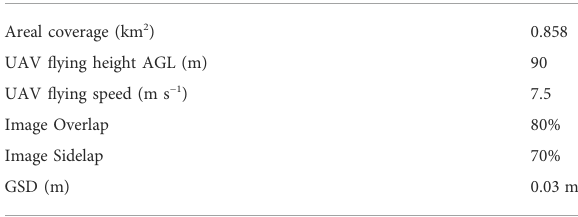
TABLE 2 Details of the fl ight parameters used when undertaking the UAV-SfM surveys in this study. Survey